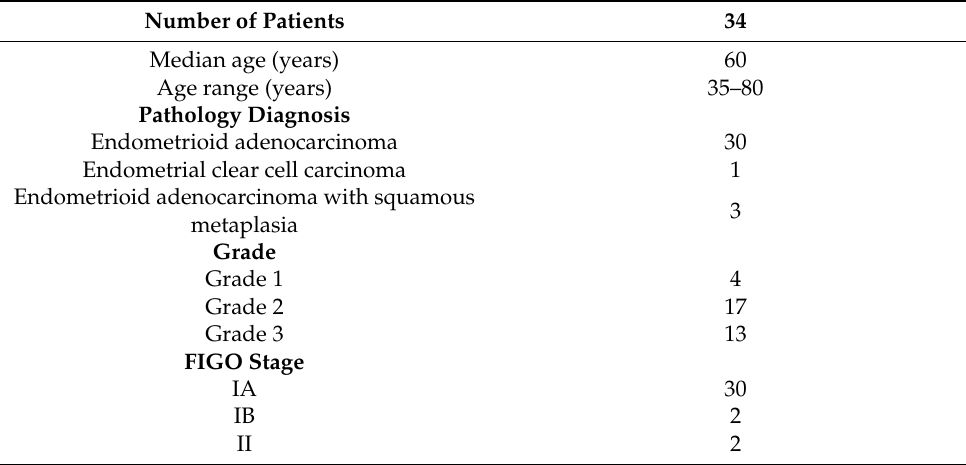
Table 1. Endometrial cancer patient